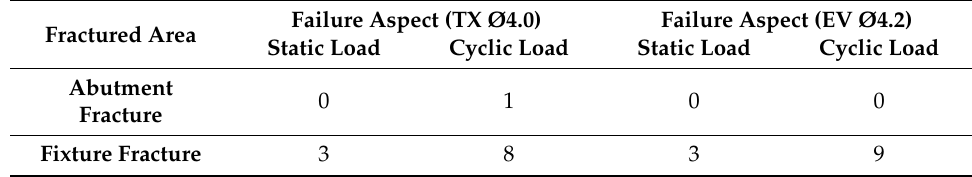
Table 4. Fisher’s exact test showed no di ff erence between fractured areas ( P > 0.99).